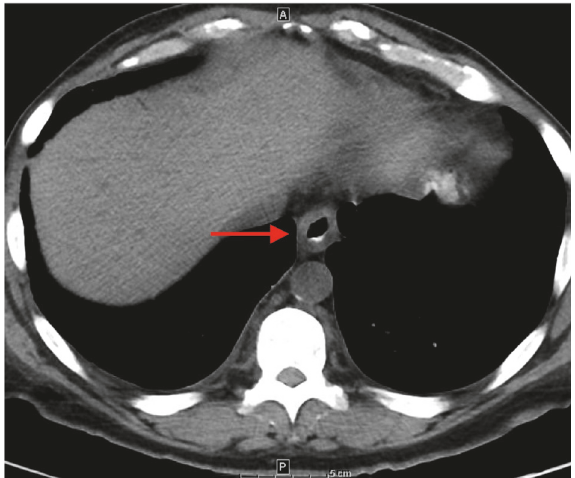
Figure 4: CT scan showing circumferential thickening of the distal